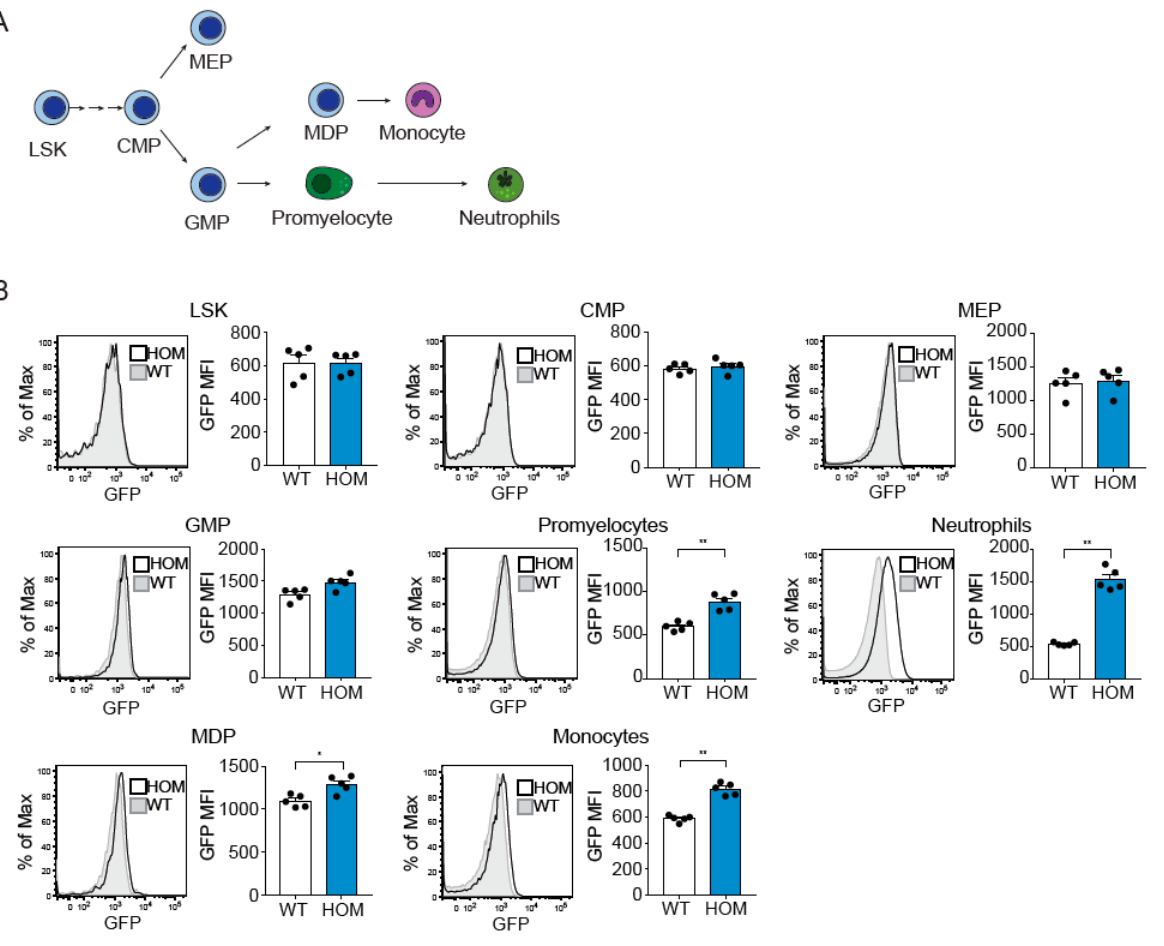
Figure 2. The ATTAC transgene in hMRP8-ATTAC mice starts to be expressed at the GMP level in the bone marrow. ( A ) Schematic representation of the hematopoietic tree indicating the different steps of myelopoiesis. ( B ) Representative histograms of GFP expression and quantification of the Median Fluorescence Intensity (MFI) of GFP in different hematopoietic cell populations depicted in ( A ) the bone marrow of homozygous female hMRP8-ATTAC mice and WT littermates ( n = 5/group), as determined by flow cytometry. WT, wild type; HOM, homozygous. LSK, Lineage - SCA1 + Kit - ; CMP, common myeloid progenitor; MEP, megakaryocyte-erythroid progenitor; GMP, granulocyte- monocyte progenitor; MDP, monocyte-dendritic cell progenitor. Data presented in B are mean values ± SEM. * p < 0.05, ** p < 0.01 by Mann–Whitney test.